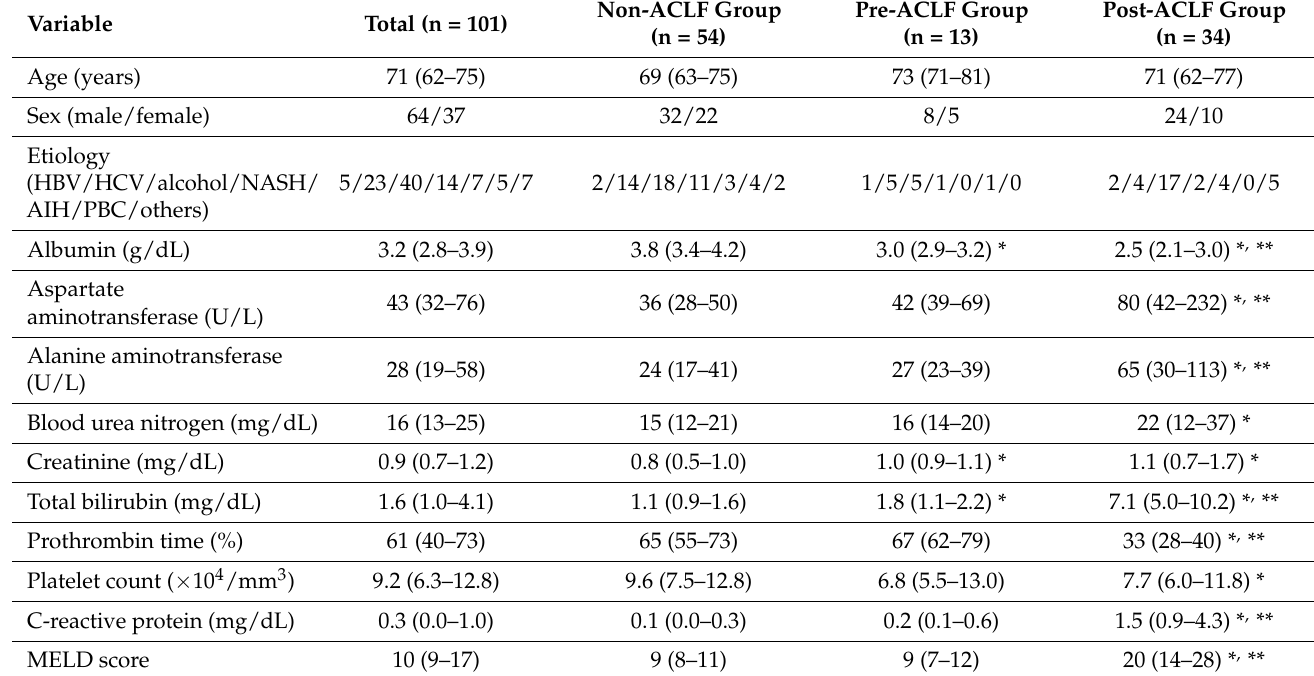
Table 1. Characteristics of patients with liver